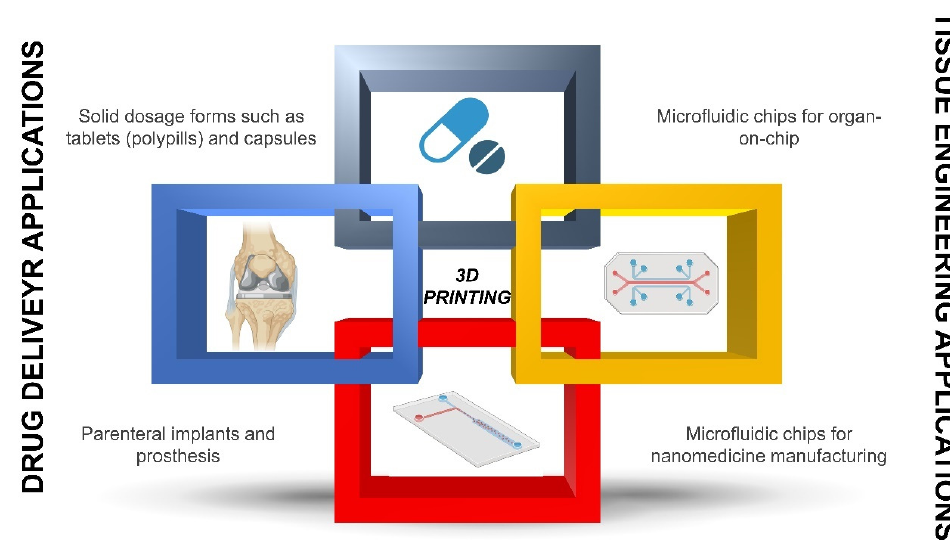
Figure 1. Application of 3D printing in personalized medicine.